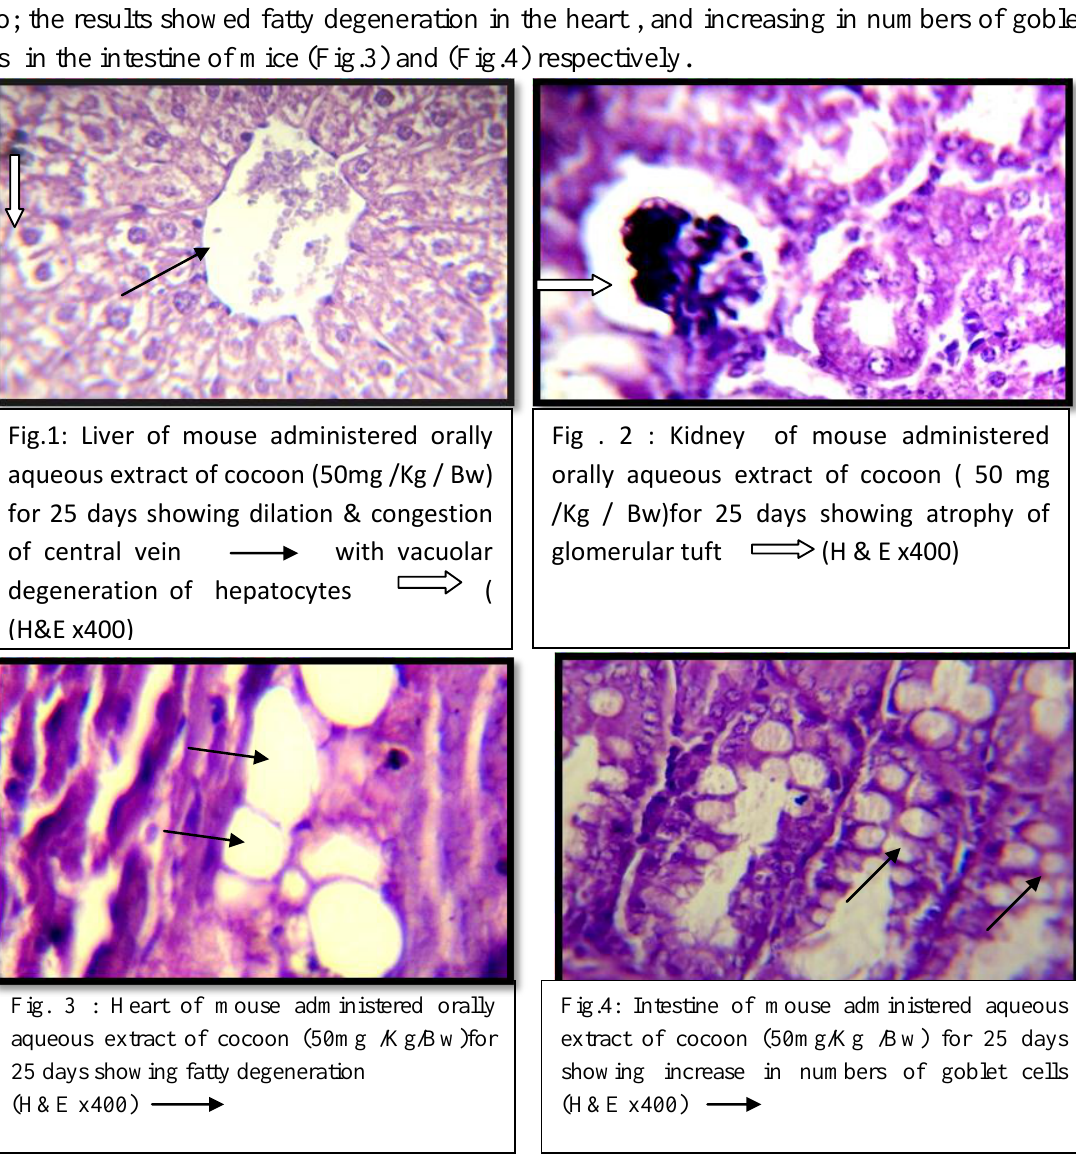
Fig.4: Intestine of mouse administered aqueous extract of cocoon (50mg/Kg /Bw) for 25 days showing increase in numbers of goblet cells (H&E